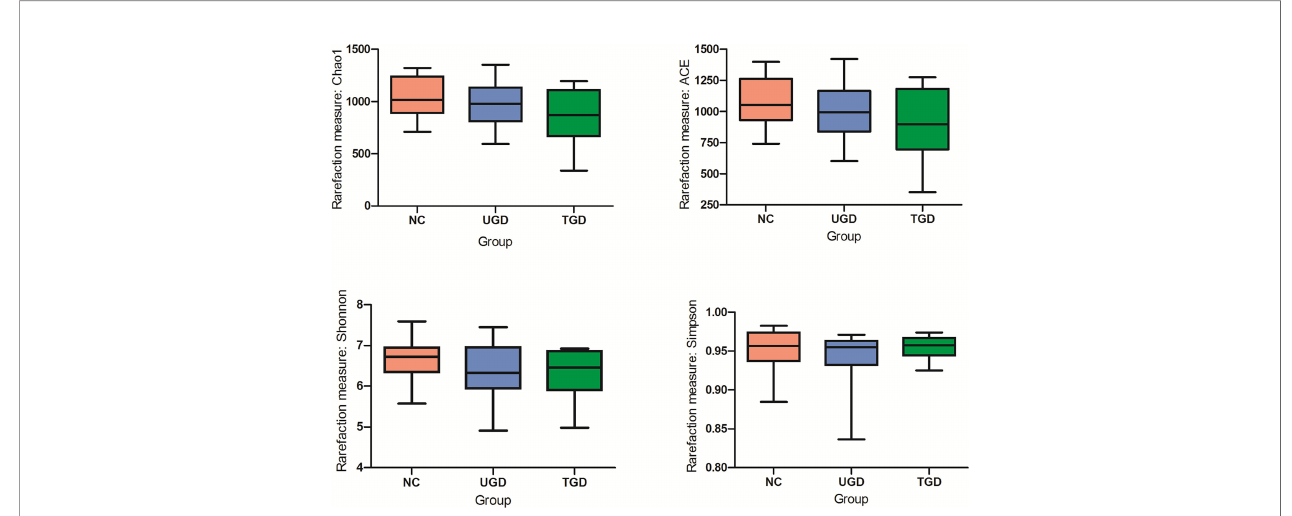
FIGURE 2 | Signi fi cance of the alpha diversity estimators among the three groups.